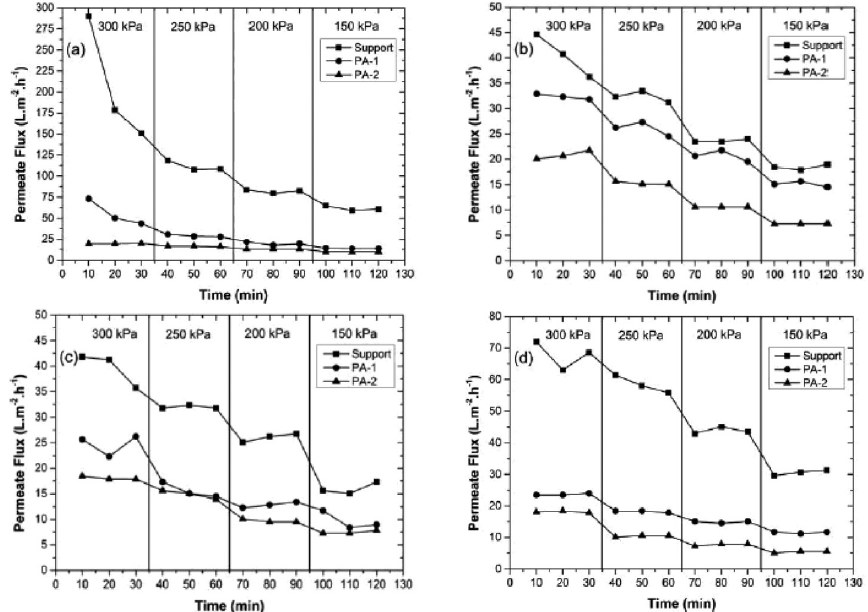
Figure 2. Water flux tests (a) starting with pure water, (b) after the ultrafiltration with oil concentration of 50 mg∙L -1 , (c) after ultrafiltration test with oil concentration of 100 mg∙L -1 and (d) after the ultrafiltration with oil concentration of 200 mg∙L -1